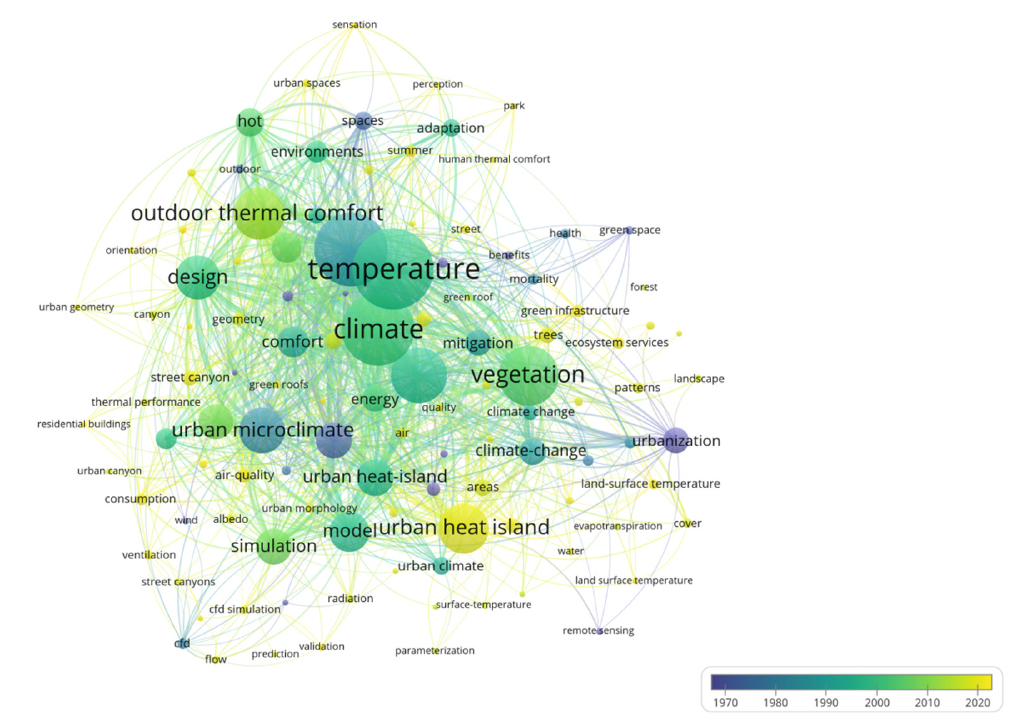
Figure 7. Annual overlap mapping of urban microclimate studies.